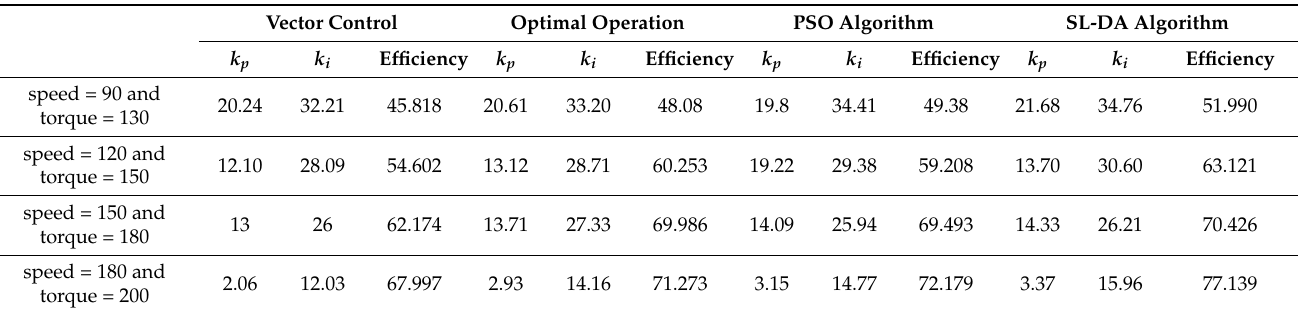
Table 5. Obtained proportional and integral values of conventional method and proposed SL-DA